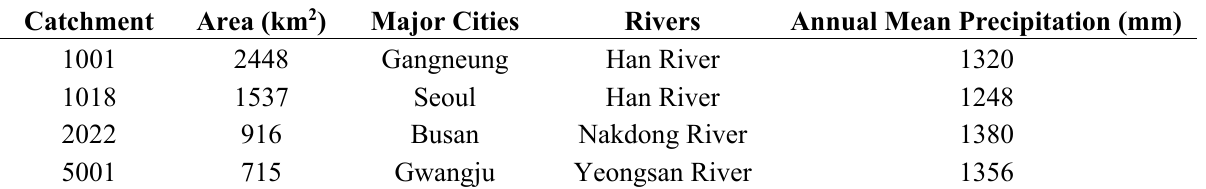
Table 1. Characteristics of the four test catchments.